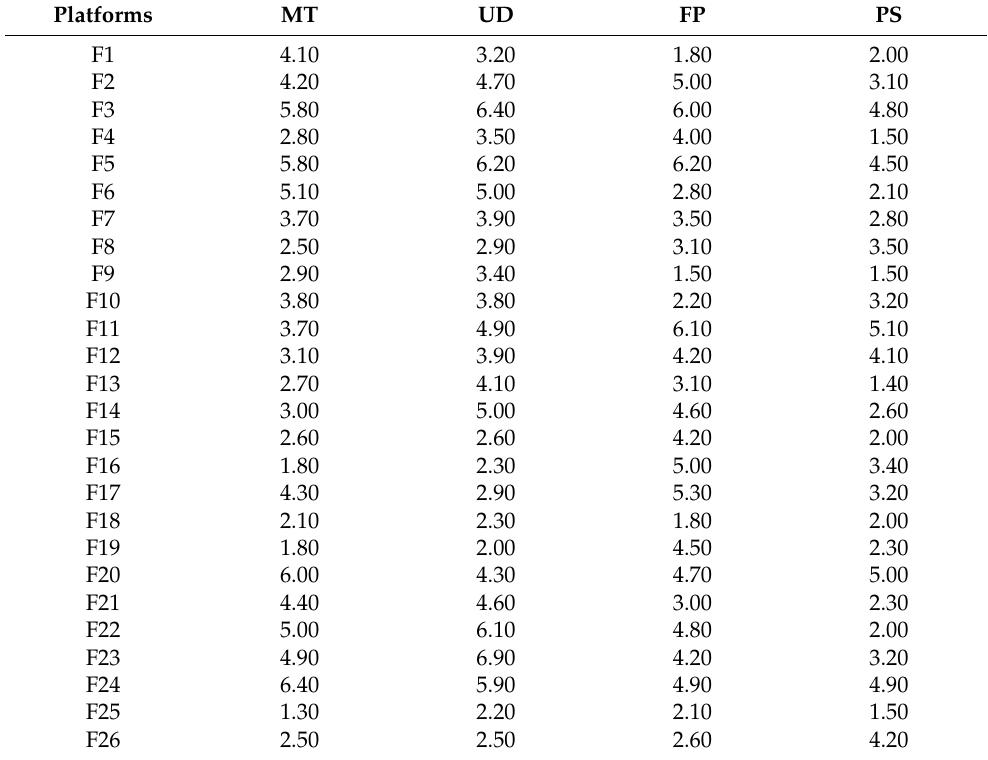
Table 5. Results of the decision